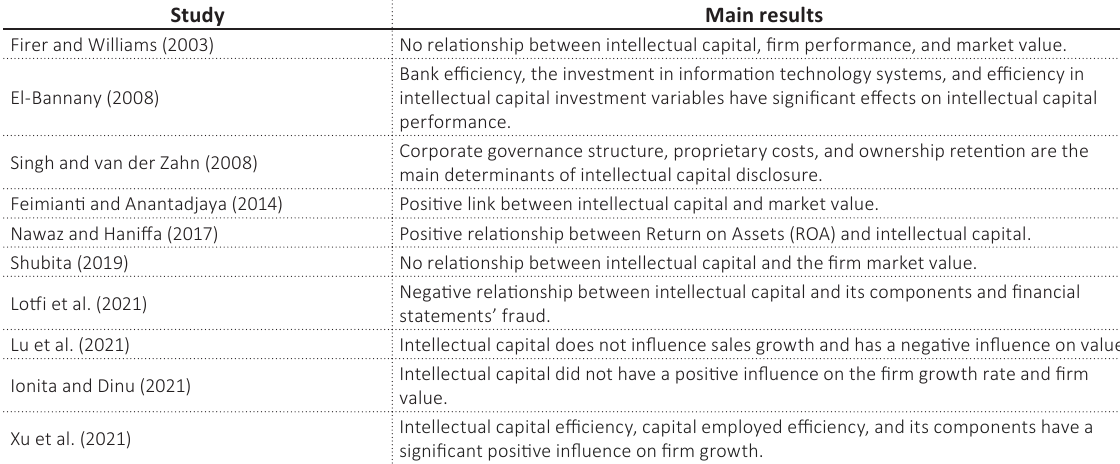
Table 1. Literature review summary Study Main